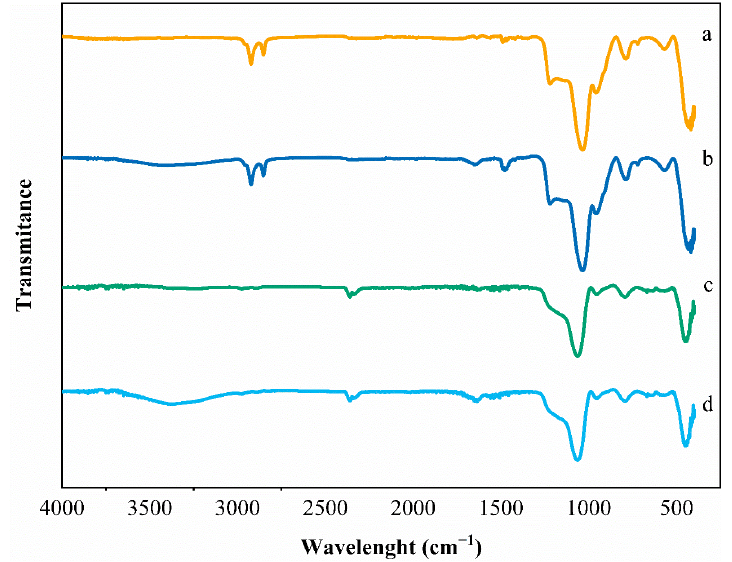
Figure 3. FT-IR of mesoporous silicon nanoparticles: (a) MCM-41; (b) Thy-MCM-41; (c) SBA-15; and (d) Thy-SBA-15.